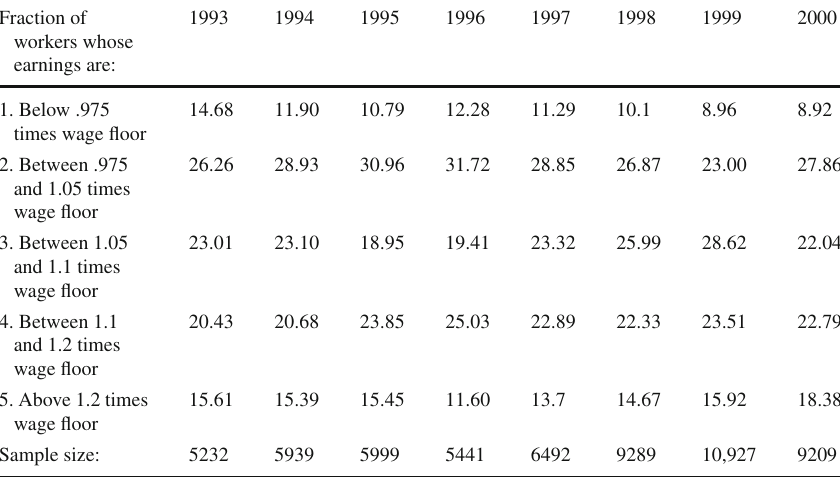
Table 13 The bite of collective contracts in the construction sector: laborers 18–35. Source : Muestra Continua de Vidas Laborales (1993–2000) matched to the Registro de Convenios Colectivos Fraction of workers